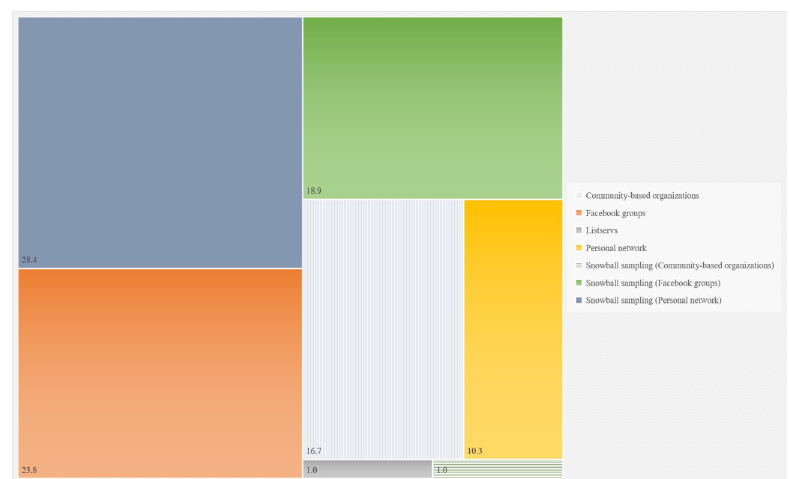
Fig 3. Percentages of participants in the survey sample from different recruitment